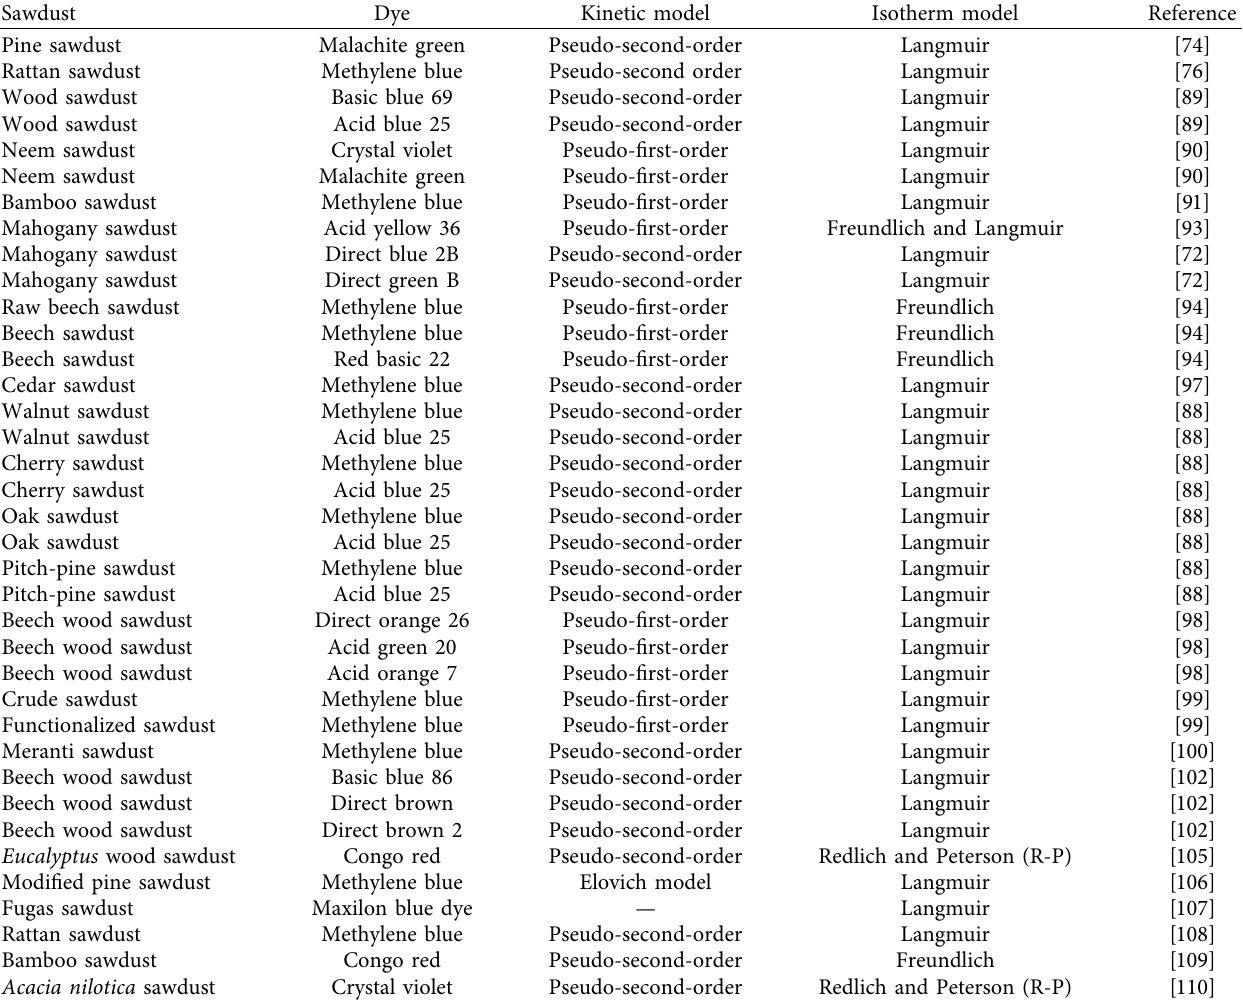
Table 7: Various kinetic and isotherm studies for dye adsorption by various sawdust.